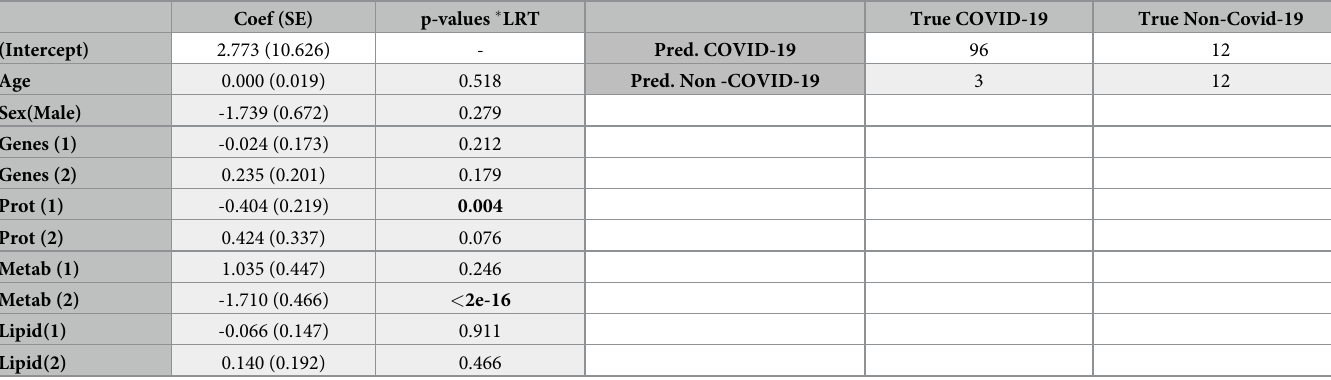
Table 22. Logistic regression using smCCA